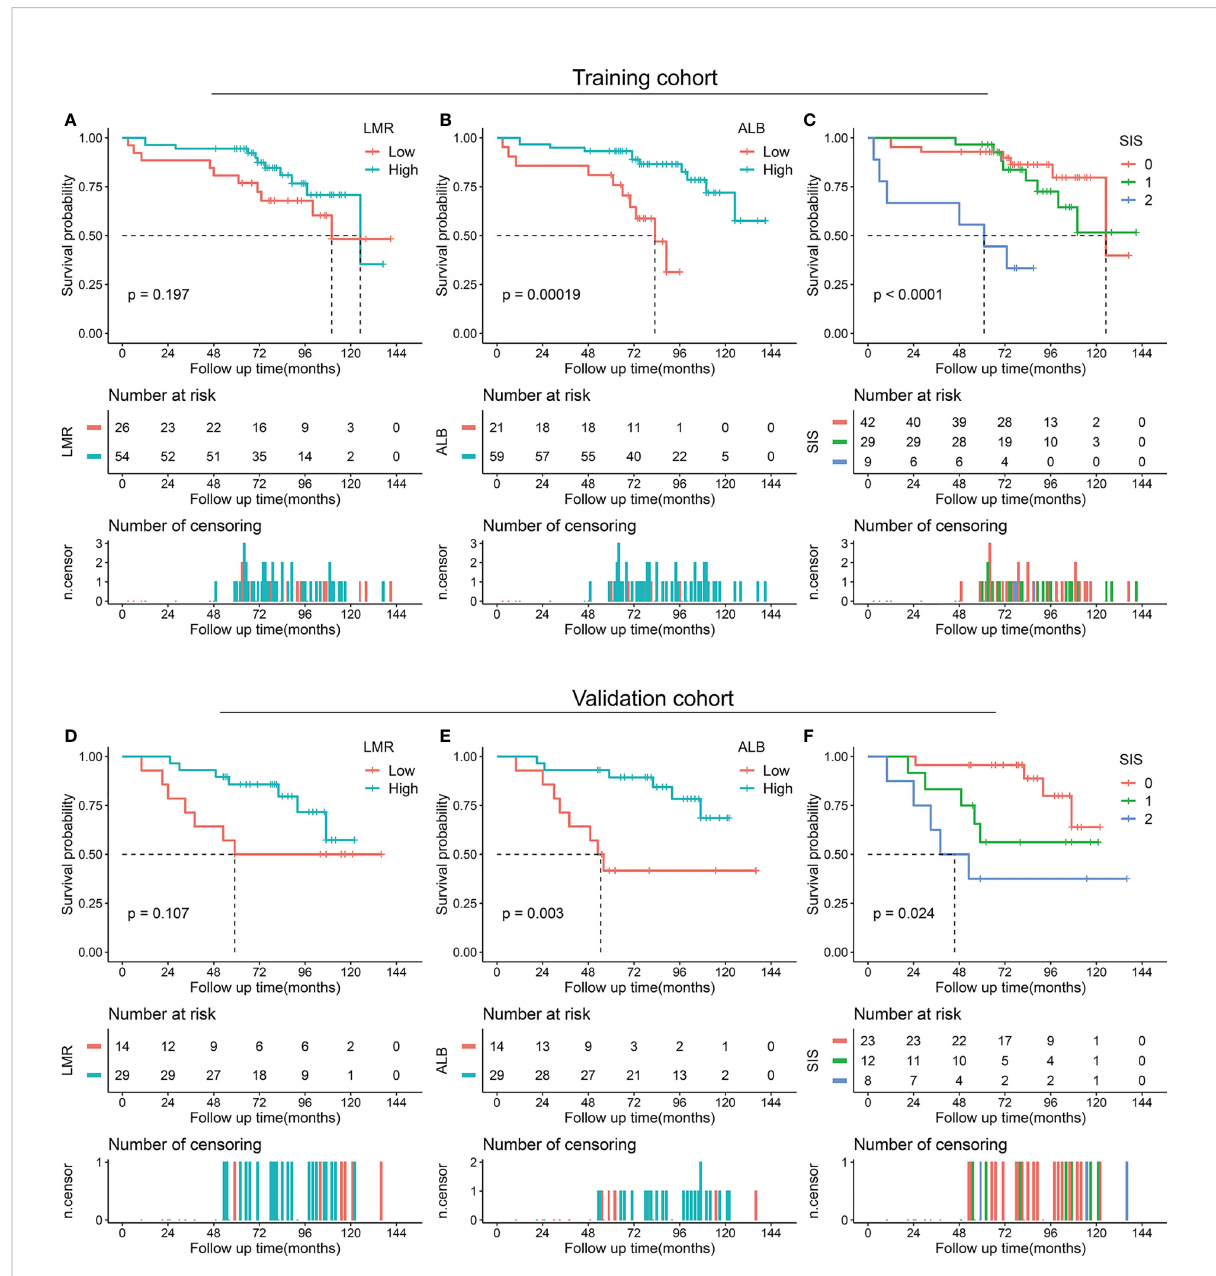
FIGURE 3 Kaplan-Meier survival analysis of LMR, ALB, and SIS in skull base chordoma with total or subtotal resection. (A) OS analysis of LMR in the training cohort. (B) OS analysis of ALB in the training cohort. (C) OS analysis of SIS in the training cohort. (D) OS analysis of LMR in the validation cohort. (E) OS analysis of ALB in the validation cohort. (F) OS analysis of SIS in the validation cohort. LMR, lymphocyte to monocyte ratio; ALB, albumin; SIS, systemic in fl ammation score; OS, overall